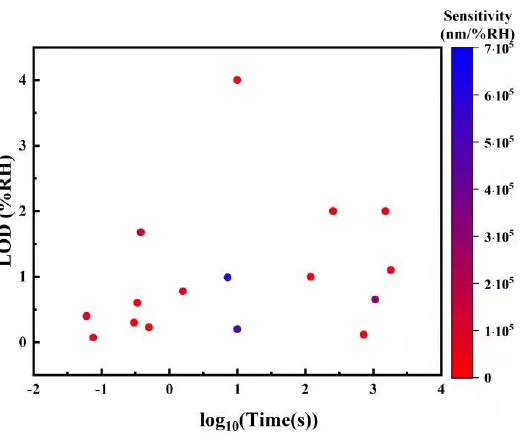
Figure 42. Relationship between log scale of time and limit of detection, with color representing sensitivity.